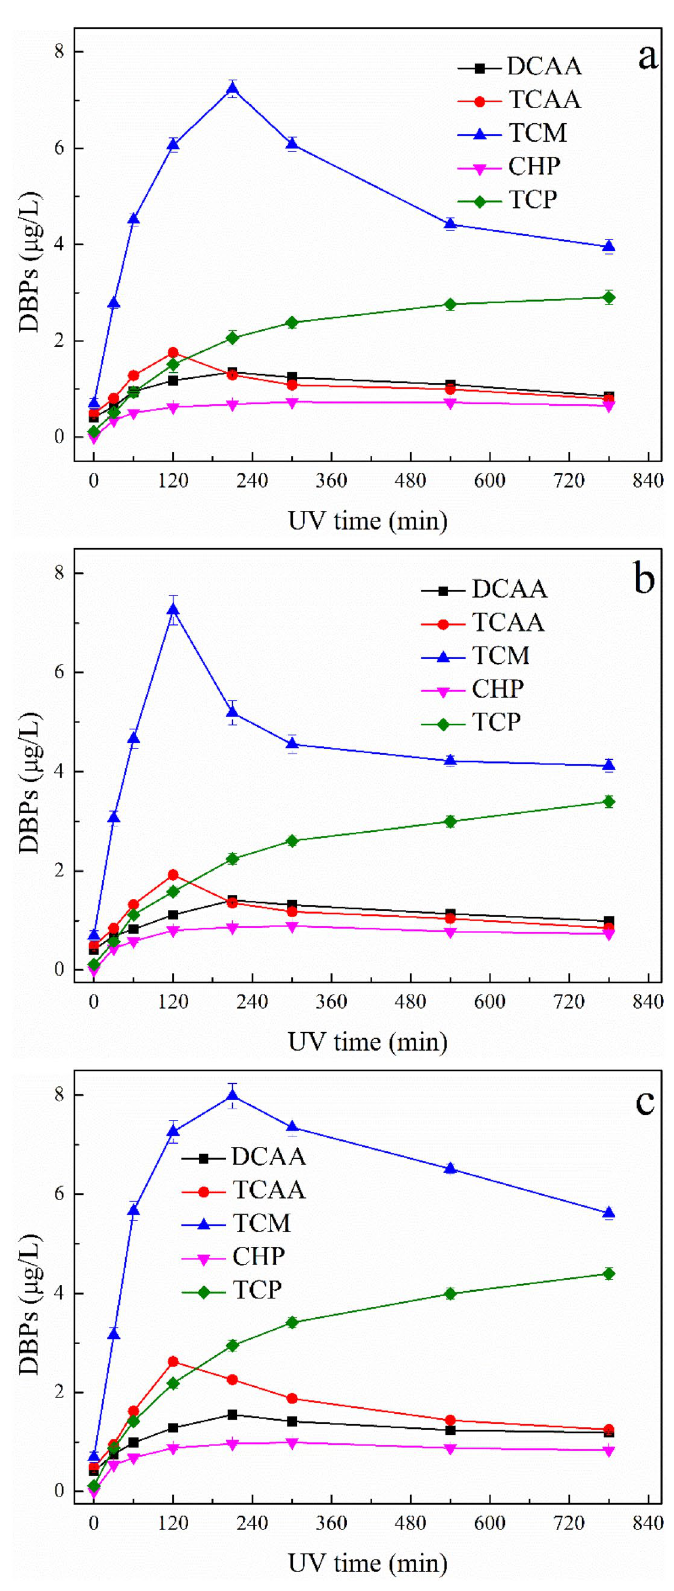
Figure 11. DBPs formations of UV/TiO 2 oxidized ATZ solutions: ( a ) pH = 4.0; ( b ) pH = 7.0; (c) pH =